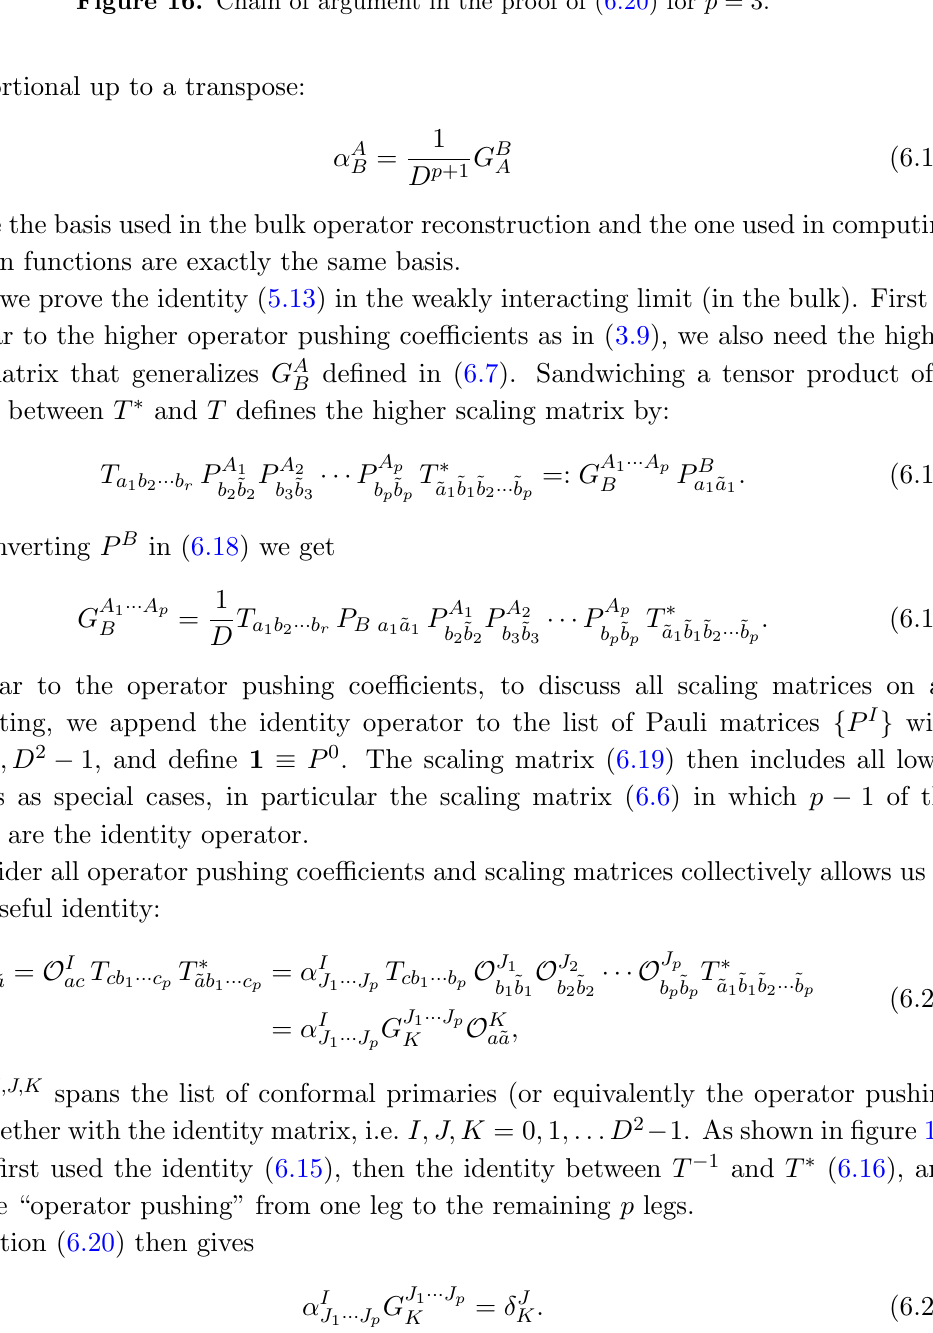
Figure 16. Chain of argument in the proof of (6.20) for p =